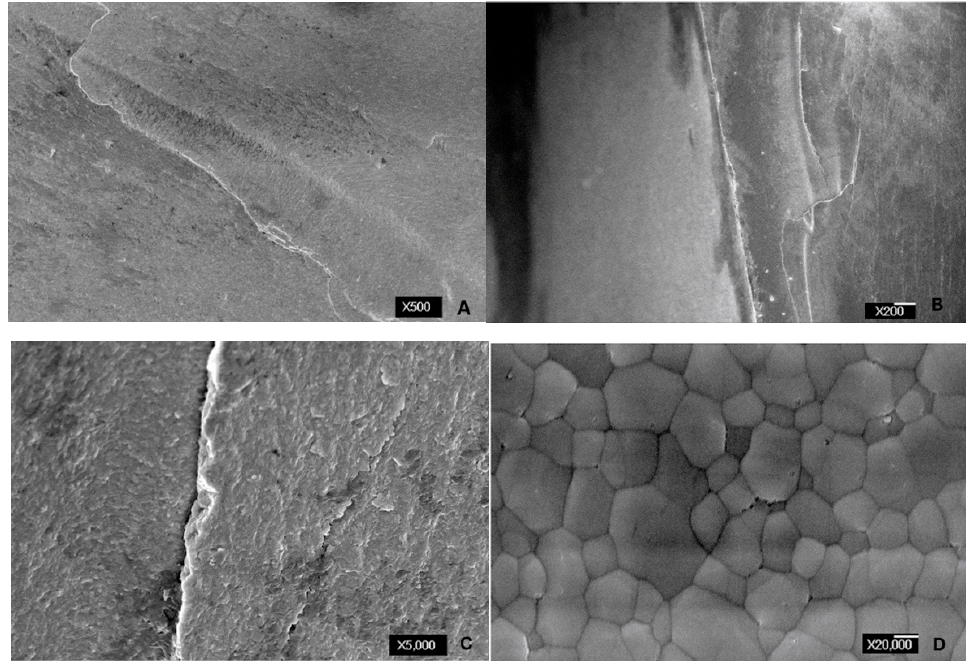
Figure 9. Scanning electron microscopic images showing fracture condition of broken segments. A, B , beach marks show fracture segments from the specimen on SA25 (original magnification ×500) SA50 (original magnification × 200). ( C ), apparent cracks observed on SA50 fracture segments (original and SA50 (original magnification ×200). C, apparent cracks observed on SA50 fracture segments magnification × 5000). ( D ), intact surface of zirconia specimens (original magnification × (original magnification ×5000). D , intact surface of zirconia specimens (original magnification ×20000) .